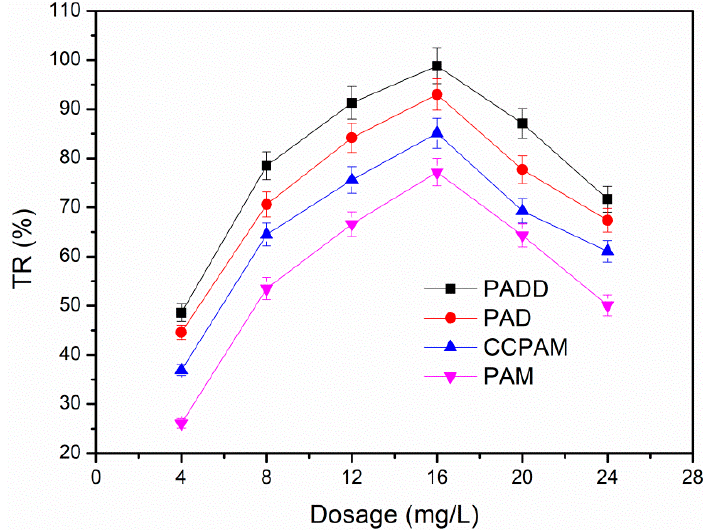
Figure 6. The effect of flocculant dosage on turbidity removal rate. Figure 6. The e ff ect of flocculant dosage on turbidity removal